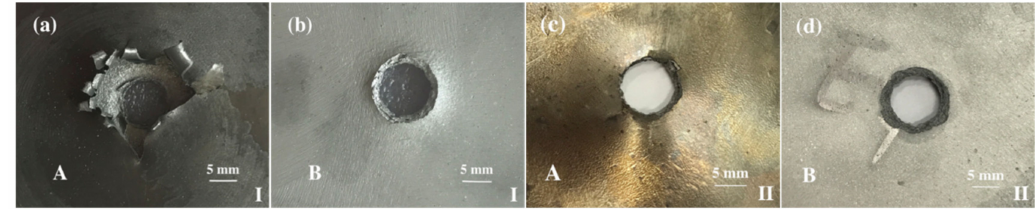
Figure 2. Macro-morphologies of the bumpers. ( a , b ) bumper I; ( c , d ) bumper